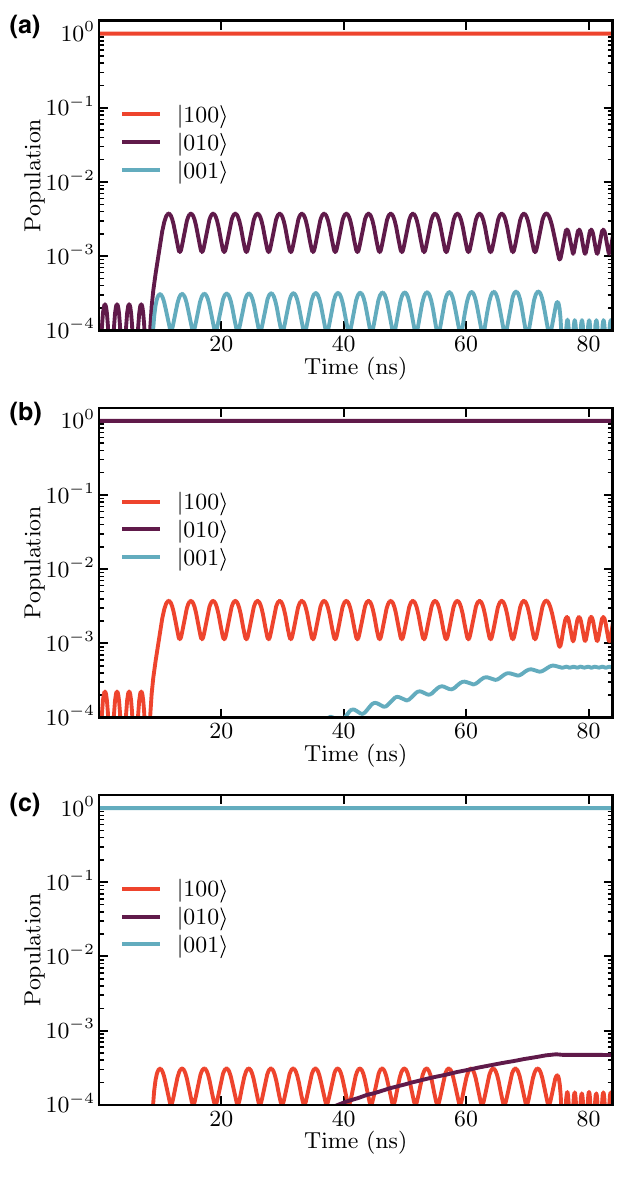
FIG. 15. Population transfers for different initial states [(a) | 100 (cid:2) , (b) | 010 (cid:2) , (c) | 001 (cid:2) ] in the one-excitation subspace in the implementation of the CCZS gate with tunable qubits. All simu- lation parameters and notation conventions are the same as for Fig. 7 in the main